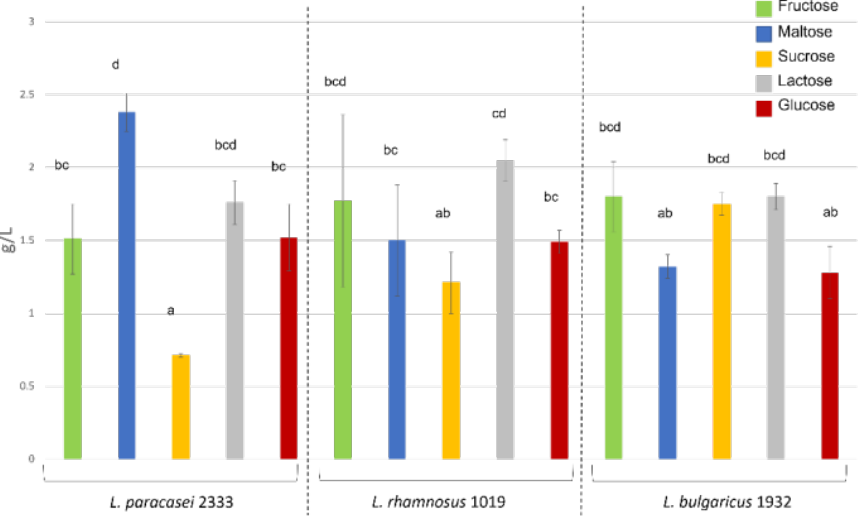
Figure 2. Amounts of EPS produced by the tested microorganisms with different carbon sources are given in g L − 1 culture broth. Different letters above the bars indicate significant differences (one-way ANOVA, p <